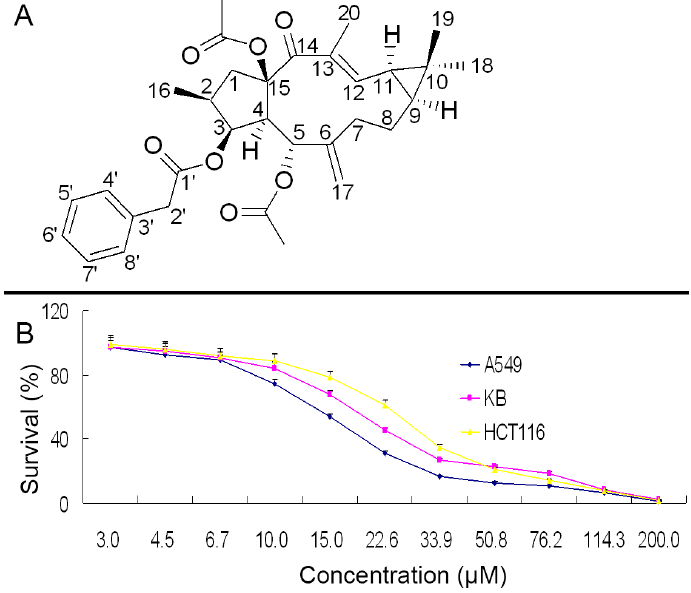
Figure 1. ( A ) Chemical structure of lathyrol-3-phenylacetate-5,15-diacetate (deoxy Euphorbia factor L1, DEFL1); ( B ) Growth inhibition curve of DEFL1 against A549, KB and HCT116 cells.